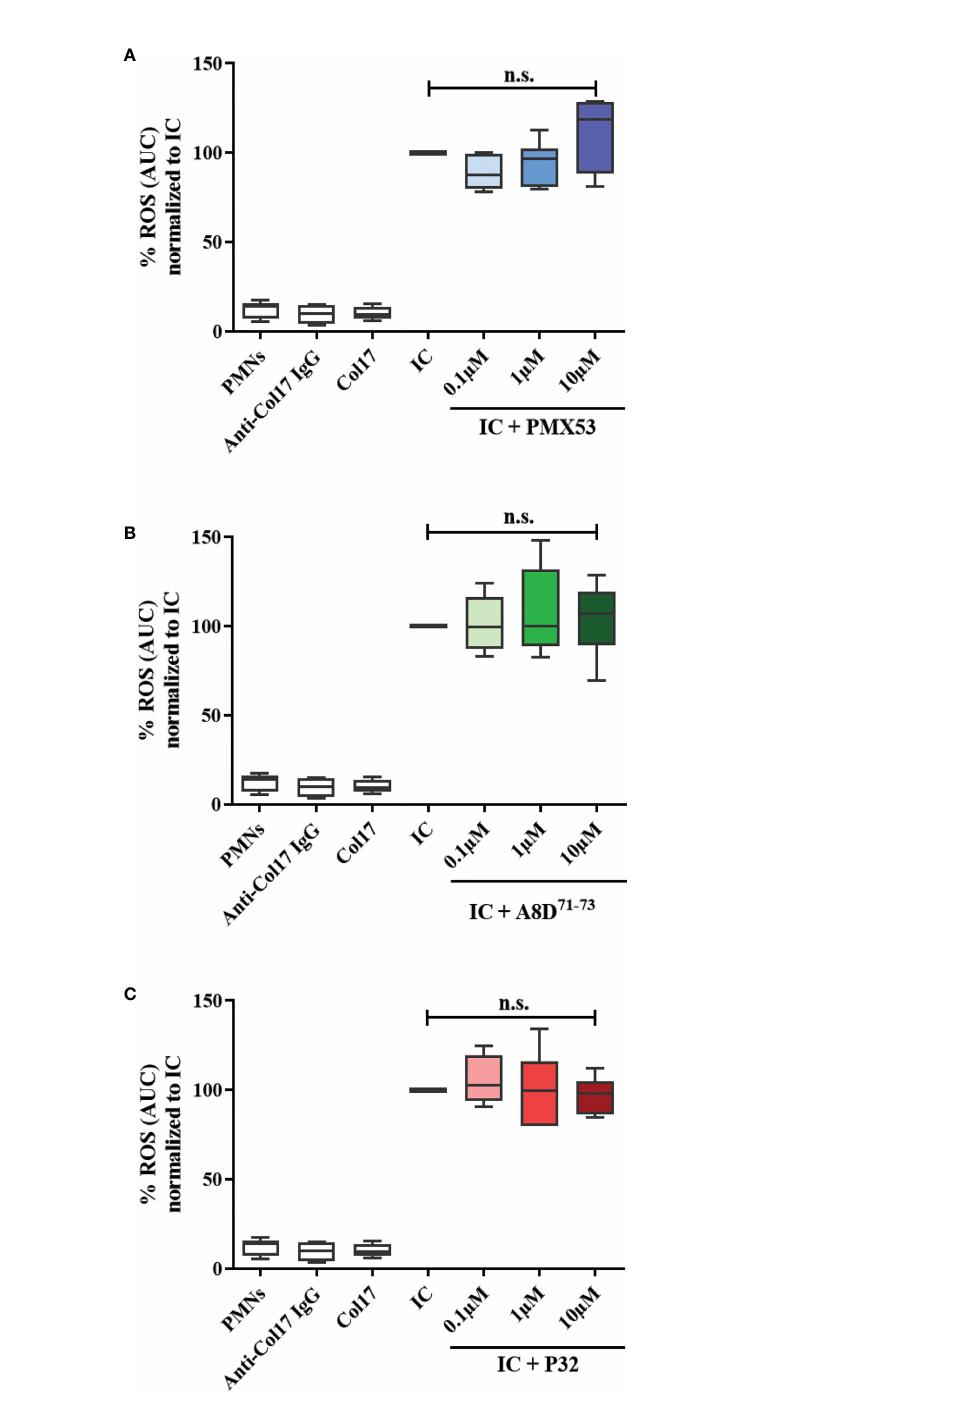
FIGURE 6 CaR1 and C5aR2 (ant)agonists have no effect on the reactive oxygen species (ROS) release from normal human polymorphonuclear leukocytes (PMNs) after stimulation with immune complexes (IC) of human Col17 and anti-Col17 IgG. PMNs of healthy volunteers (n=6) were activated with immobilized ICs of human Col17 and anti-Col17 IgG with or without the C5aR1 antagonist PMX53 (A) , the C5aR2 agonist P32 (B) , and the dual C5aR1/2 antagonist A8D 71-73 (C) at three different concentrations (0.1, 1, and 10 µM). ROS release was tracked for 2 h and the AUC (cumulative values) of luminescence were calculated. Data were normalized to positive control (IC-stimulated PMNs). PMNs without or with antibody (anti-Col17 IgG) or antigen (Col17) served as negative controls. Results were pooled from six independent experiments with PMNs from different donors (n=6) and are presented as mean ± SEM. Data were analyzed using two-way ANOVA with Holm-S ̌ ı ́ da ́ k ’ s multiple-comparisons test. n.s., not signi fi cant; AUC, area under